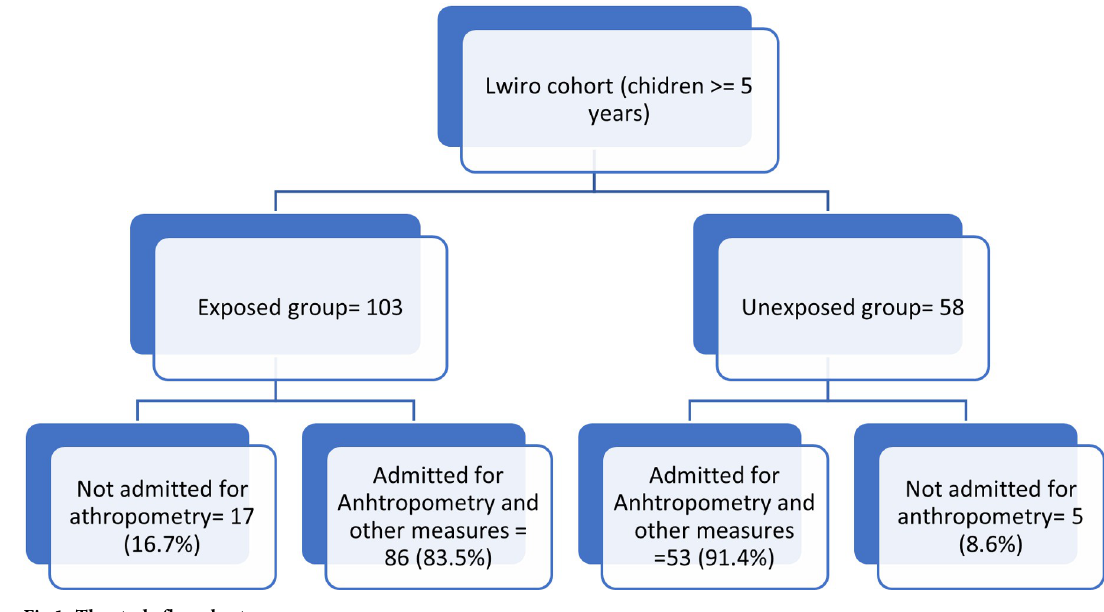
Fig 1. The study flow